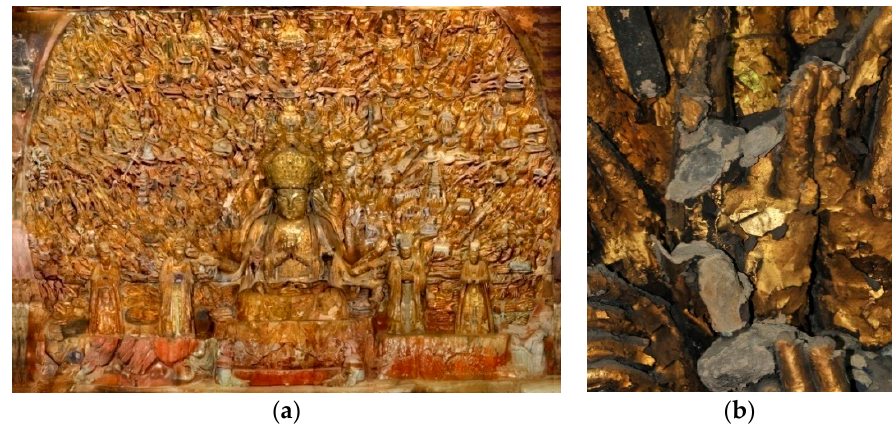
Figure 3. Dazu Thousand-Hand Bodhisattva statue: ( a ) orthophoto map; ( b ) one damaged hand.